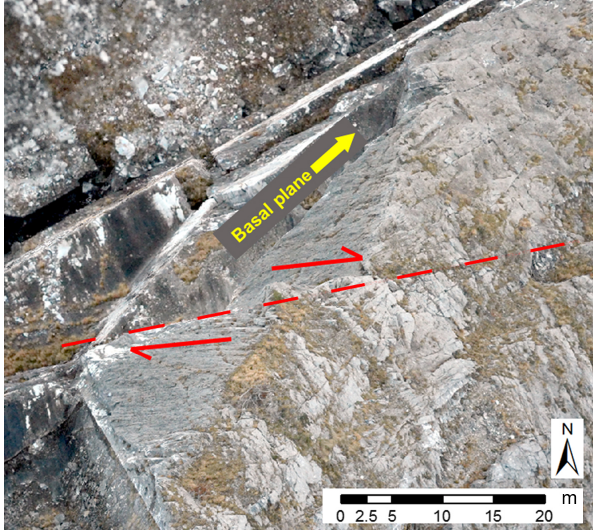
Figure 12. Detail of the zenithal orthophoto with indication of ap- parent offset of a major fault acting as back release surface for Block A of Fig. 9.